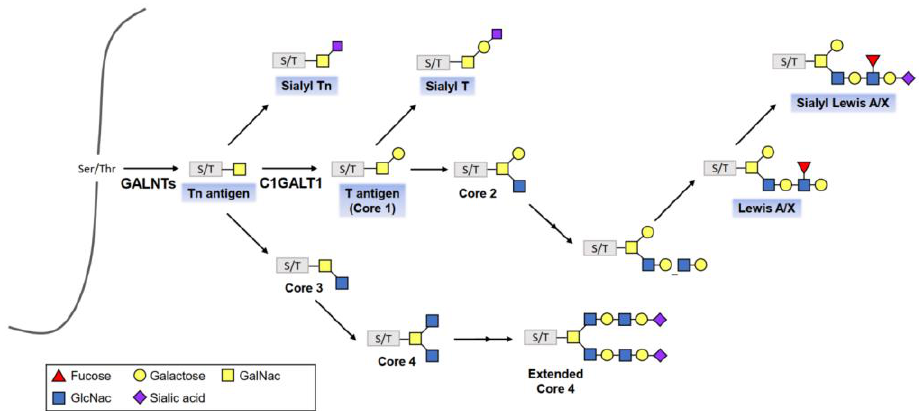
Figure 3. The O -linked glycosylation biosynthetic pathway. Cancer-associated structures are highlighted with blue boxes. With the catalyst of polypeptide-GalNAc transferases (GALNTs), a single N -acetylglucosamine (GlcNAc) residue is transferred to serine/threonine (Ser/Thr) residues of specific proteins, forming the Tn antigen, which finally forms four core structures referred to as Core 1 through Core 4.